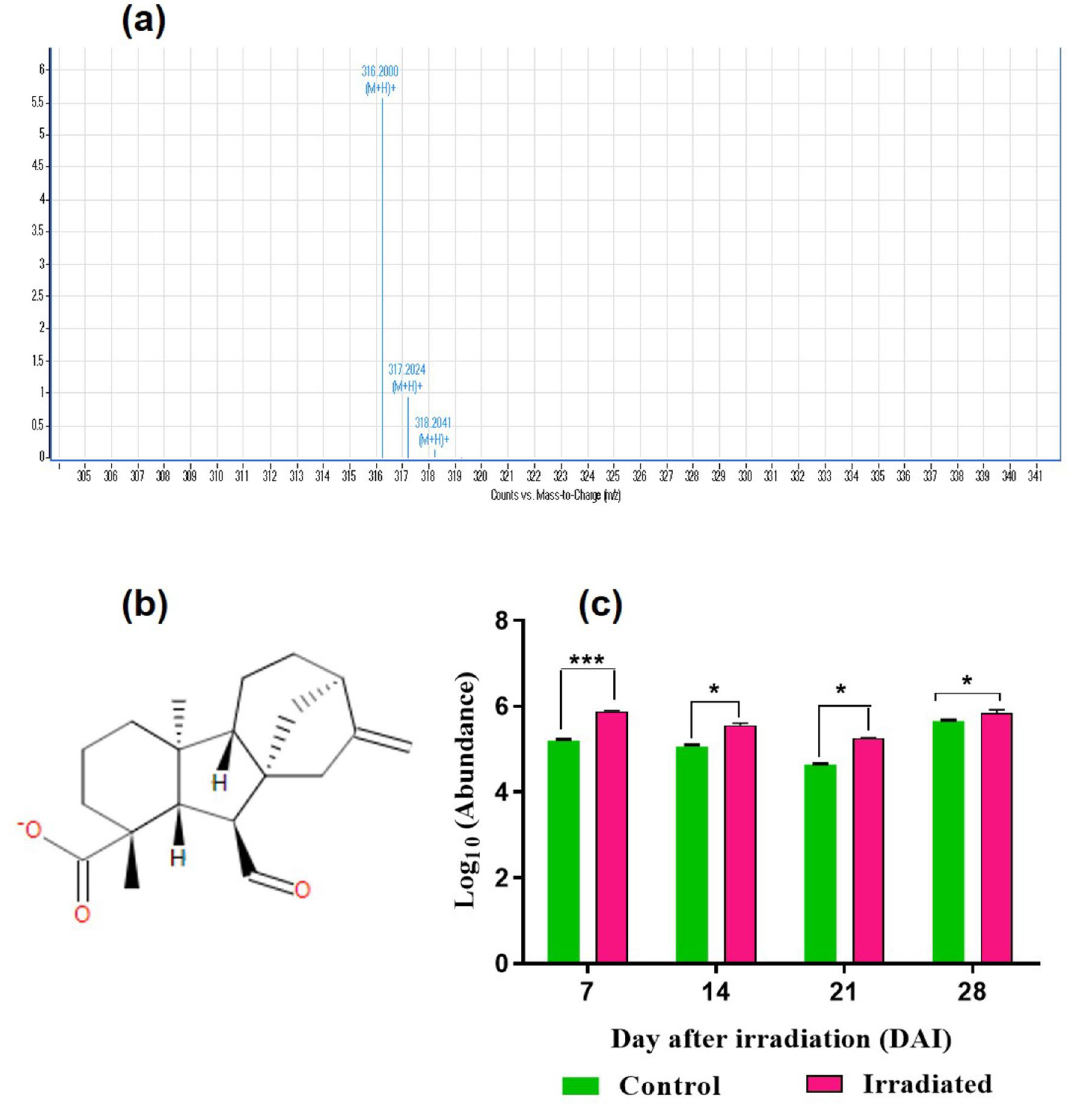
Figure 6. Detection and quantification of GA12-aldehyde from seeds and seedlings of brinjal ( Solanum melongena L.) var. Mattu Gulla in response to He–Ne laser irradiation and un-irradiated control. ( a ) HPLC– ESI–MS base peak chromatogram of GA12-aldehyde, ( b ) structure and ( c ) abundance value (log10) from the control and laser-irradiated group. Statistically significant changes in metabolite intensity between the control and laser-irradiated groups are represented as *** p < 0.001 and * p < 0.05 (n = increase in the GA content in laser-irradiated groups than in un-irradiated control. The ABA is known to be the dormancy inducer, showed a significant decrease in laser groups than un-irradiated seeds. Our results were